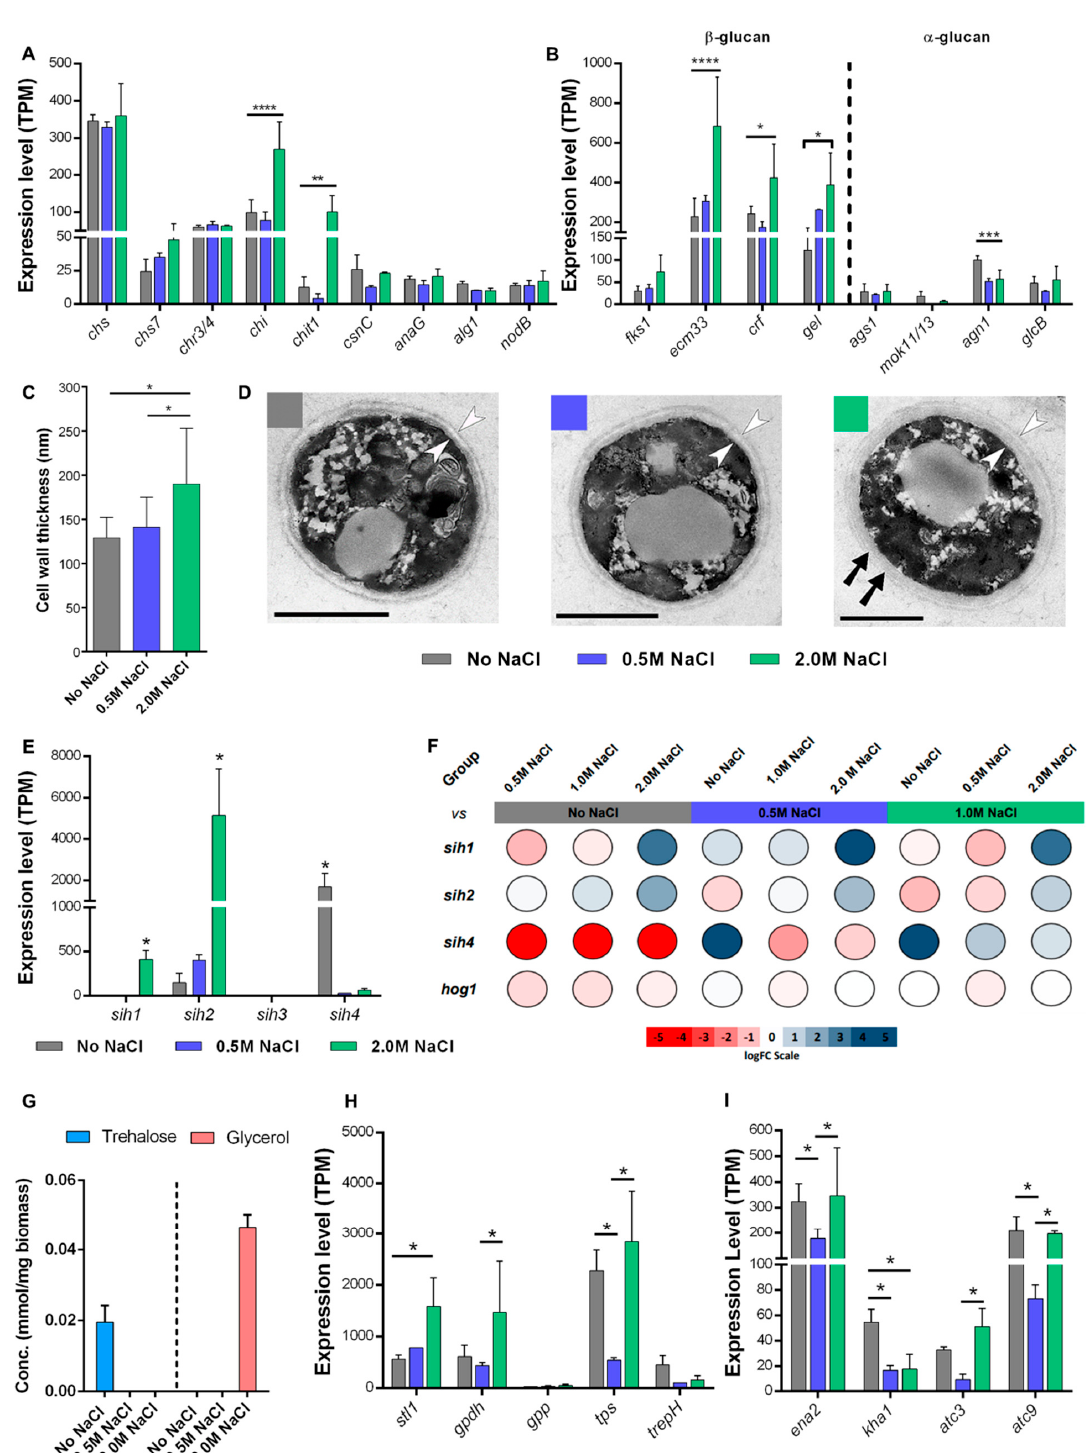
Figure 4. Mechanisms of tolerance to salinity and hyperosmotic stress identified in A. sydowii . ( A ) Cumulative expression level of transcripts associated to chitin / chitosan synthesis and degradation. ( B ) Cumulative expression level of transcripts associated to synthesis and degradation of glucans of the cell wall. ( C ) Cell wall thickness of comparable-sized hyphae. Results depicted as the averages and standard deviation of 50 measurements in each condition. Statistically significant differences (* p < 0.05) were identified by Student’s t -test. ( D ) Ultrastructural analysis of cross-sections of A. sydowii hyphae, showing lamellar structure (black arrows) and considerably thicker cell walls (arrowheads) in